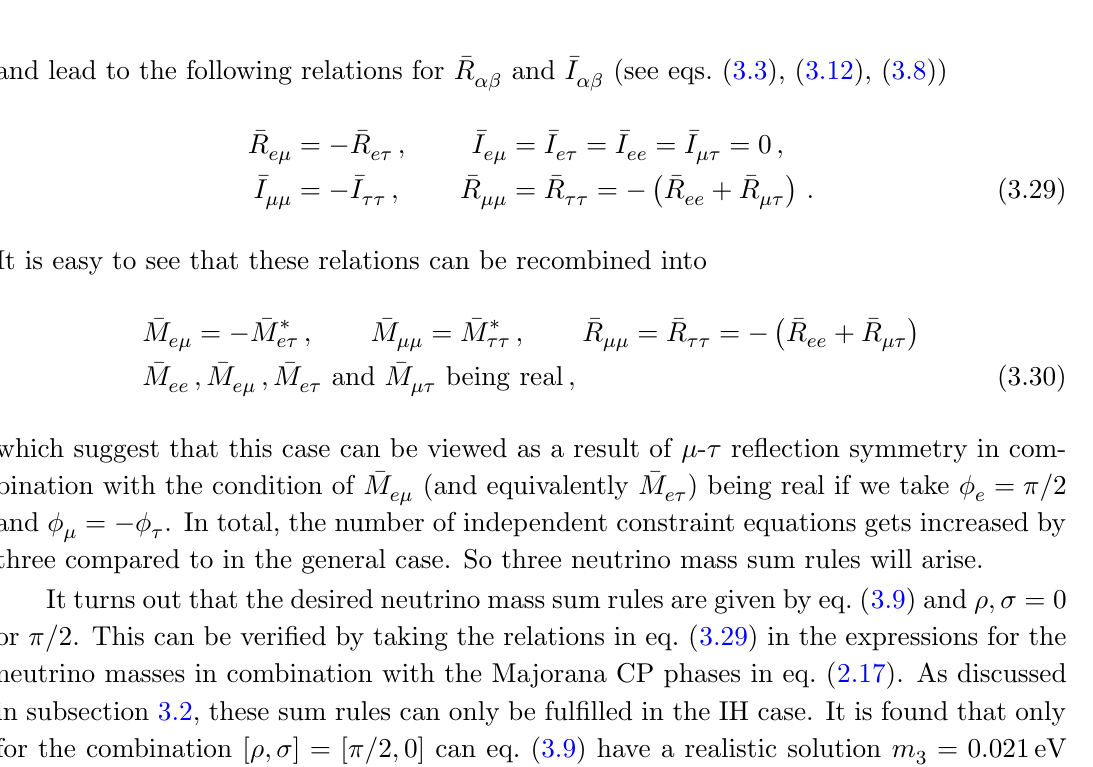
Figure 10 . (cid:26) , (cid:27) and jh m i of equations B, D and E being